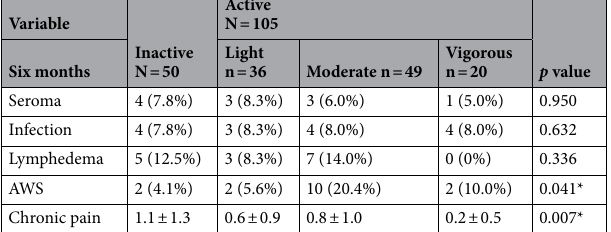
Table 4. Postoperative adverse effects. Continuous variables are presented as mean and standard deviation (SD) and categorical variables are presented as number and percentage. Significant p value (< 0.05). AWS, axillar web